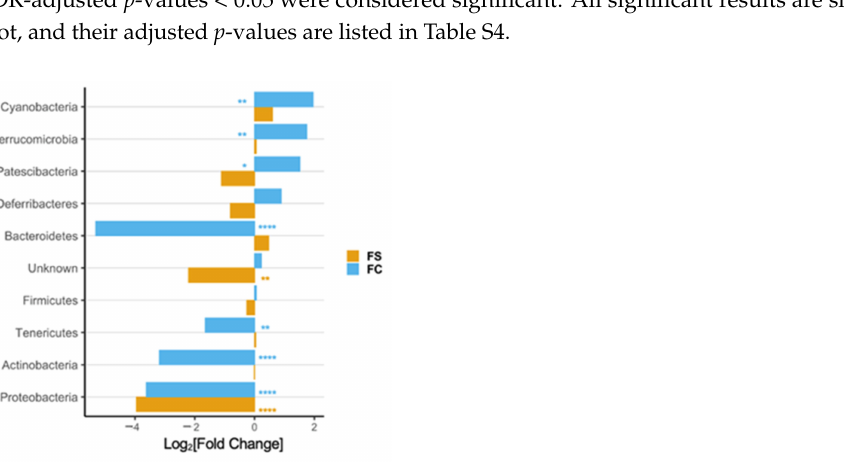
Figure 5. ( D ) Differential phyla abundance, represented as log 2 [Fold Change] from CON for each iron group ( n = 19–23/group, 4 litters/group); phyla are ordered by magnitude of change and bars are labeled with color according to iron